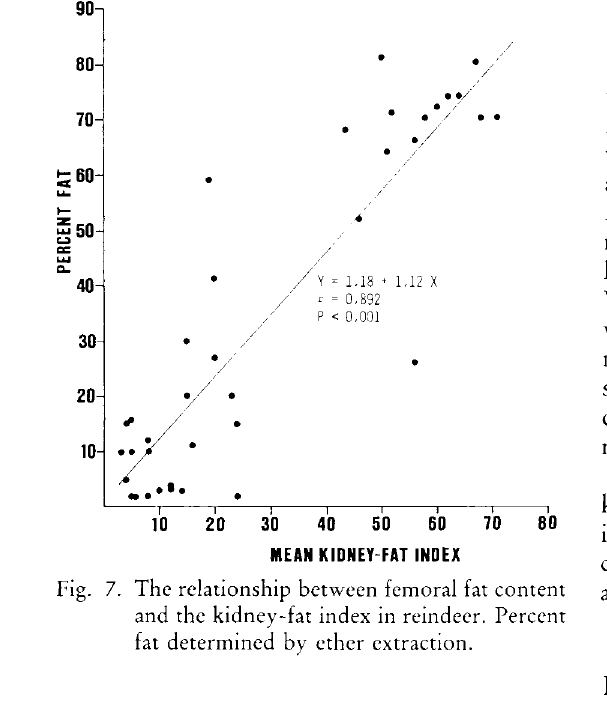
Fig. 7. The relationship between femoral fat content and the kidney-fat index in reindeer. Percent fat determined by ether